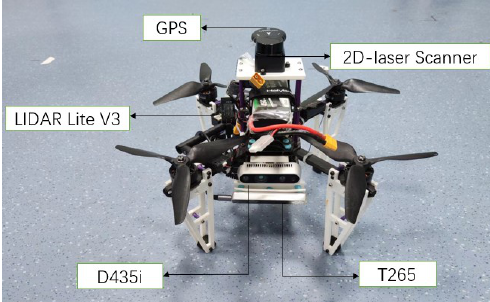
Figure 11. Four-rotor UAV experimental